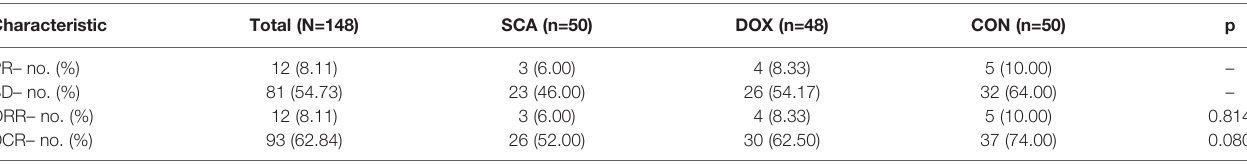
TABLE 2 | Comparison of response rate between three groups (N=148). Characteristic